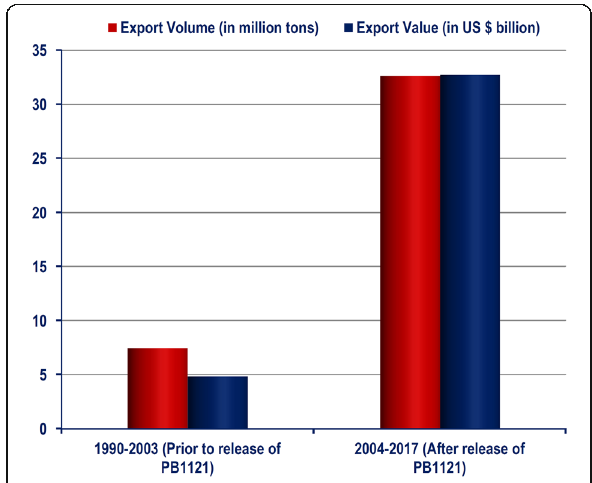
Fig. 8 Trend in Basmati export (volume and value) through export of Basmati rice in India, before and after the release of PB